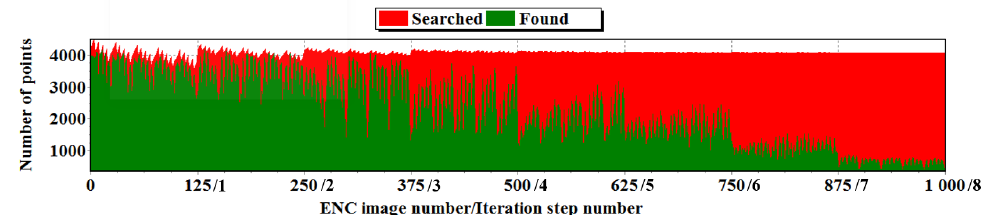
Figure 14. Graphs of the number of points in set N (“Seeking” identical points) and the number of points from set I considered identical (“found” in close proximity) during the iteration process for photograph No. 1.